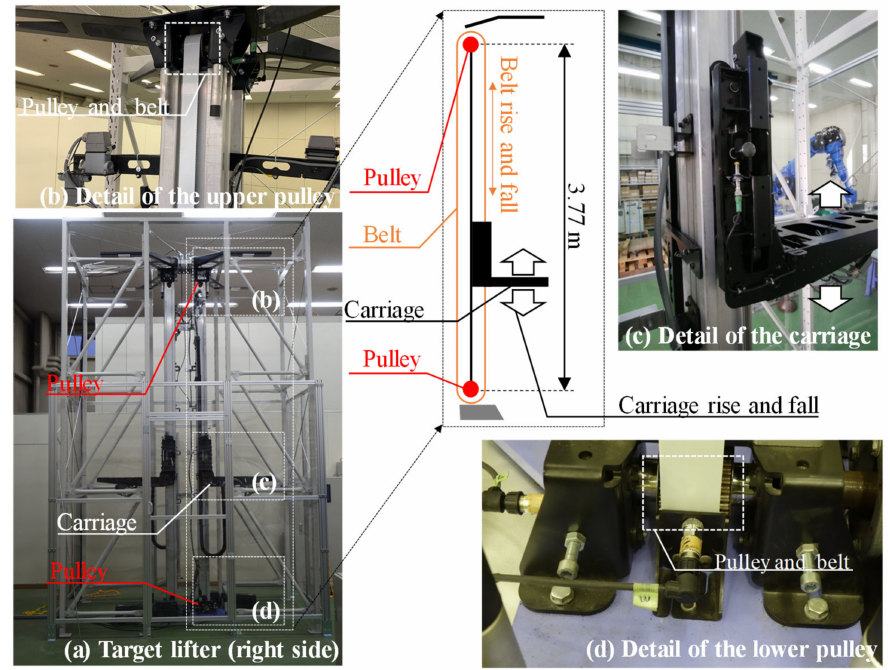
Figure 10. Detailed configuration of the target lifter. In this figure, ( a ) target lifter of the right side, details of the ( b ) upper pulley, ( c ) carriage, and ( d ) lower pulley are indicated.